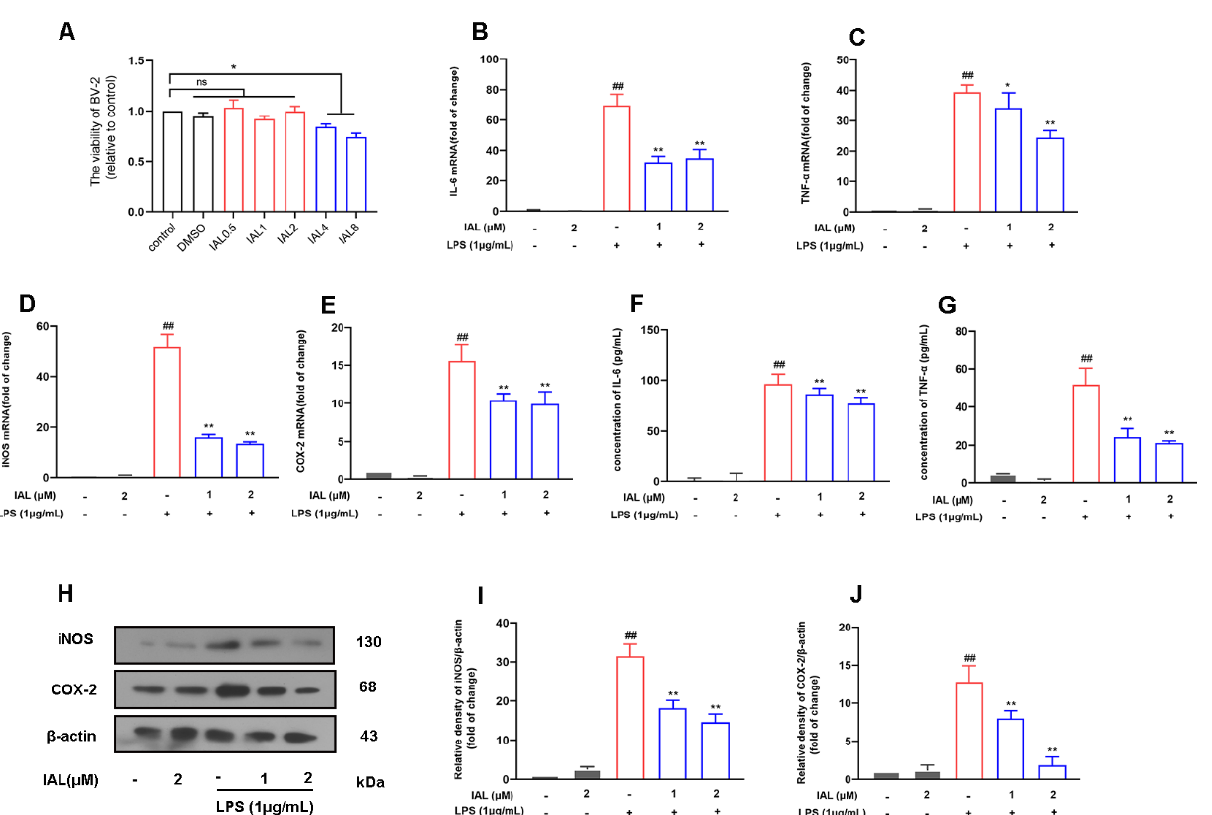
Figure 6. IAL inhibits the release of pro-inflammatory mediators in BV2 cells. ( A ) The effect of IAL on BV2 cell viability was examined with a CCK-8 assay. ( B – E ) The mRNA expression of the pro-inflammatory mediators IL-6, TNF- α , iNOS and COX2 was detected with a real-time PCR assay. ( F , G ) The protein expression of the pro-inflammatory mediators IL-6 and TNF- α was detected with an ELISA assay. ( H – J ) The protein expression of the pro-inflammatory mediators (iNOS and COX2) was detected with a Western blot assay. Results are shown as means ± SEM (n = 3). ns stands for no significant difference. ## p < 0.01, * p < 0.05 and ** p < 0.01 stand for biologically significant differences.